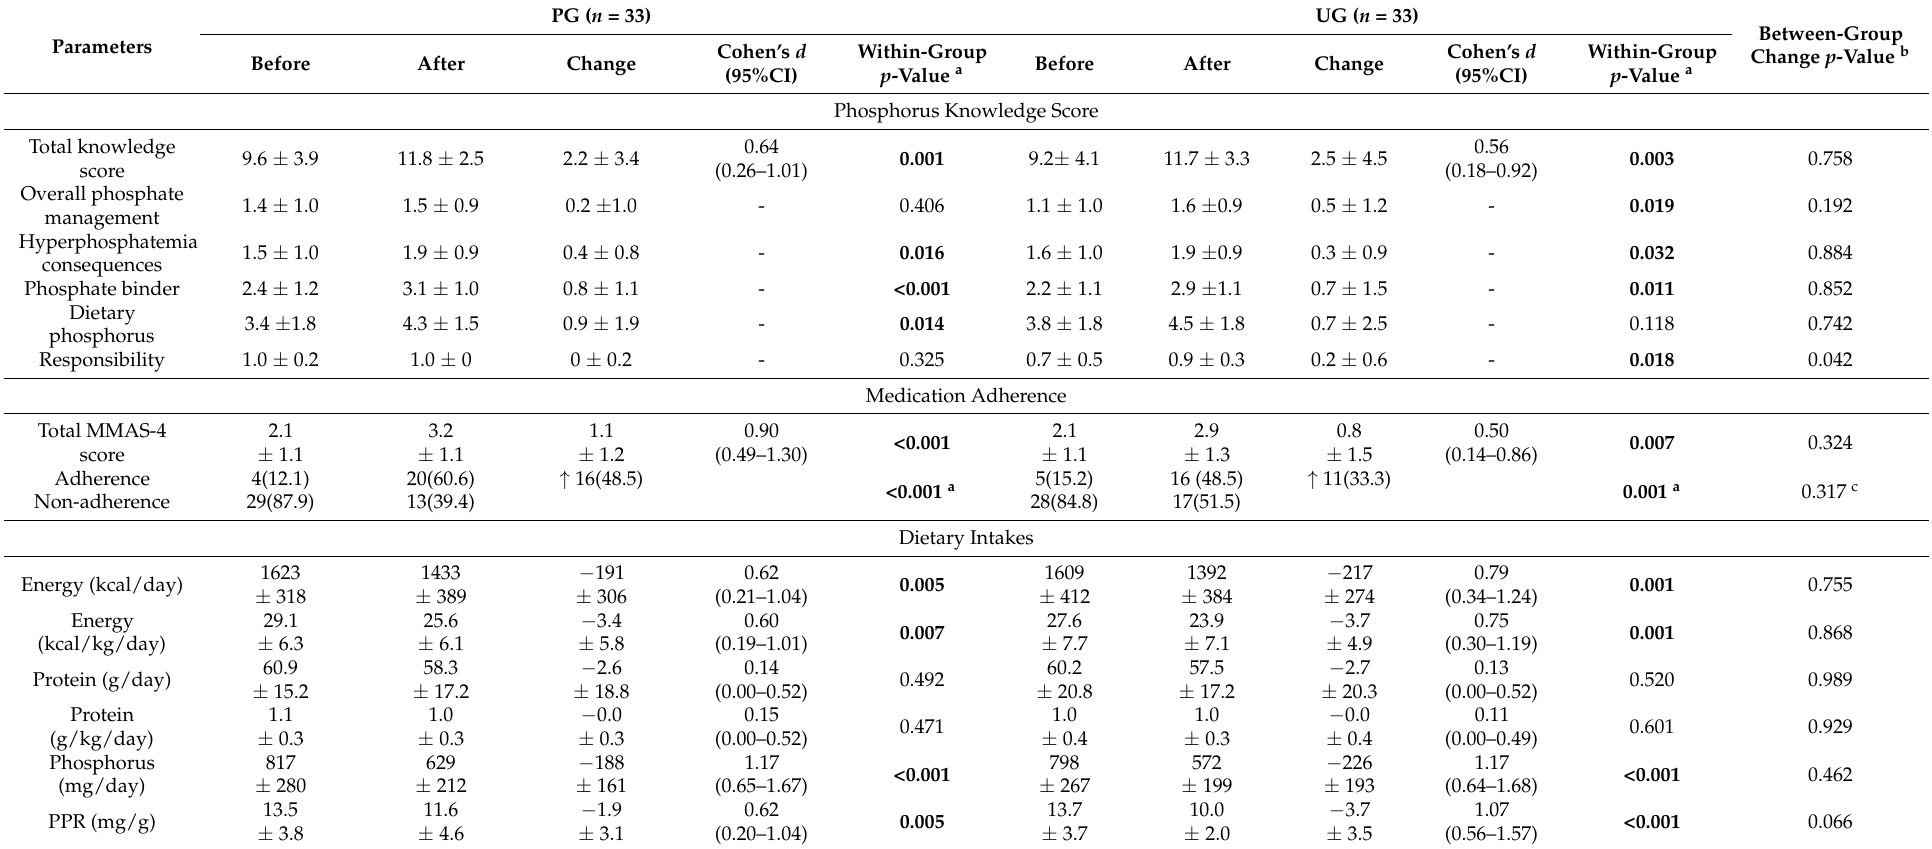
Table 3. Effects of intervention on phosphorus knowledge score, medication adherence, and dietary